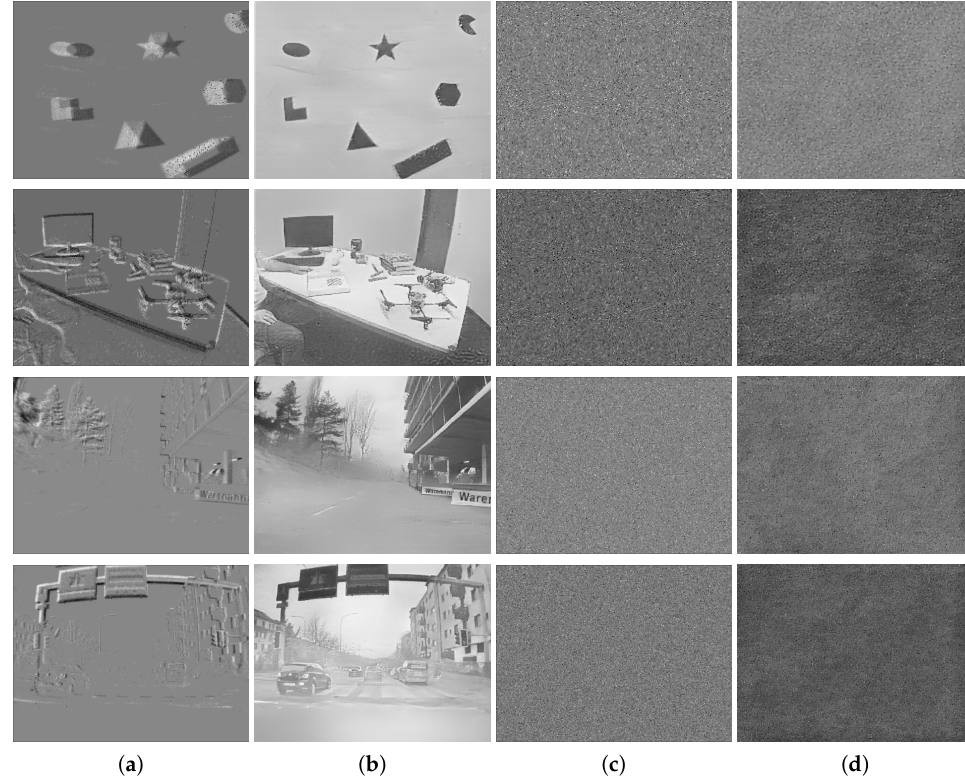
Figure 7. The qualitative evaluation of encryption. ( a ) The event images based on unencrypted events. ( b ) The reconstructed images based on unencrypted events. ( c ) The event images based on encrypted events using the proposed algorithm. ( d ) The reconstructed images based on encrypted events using the proposed